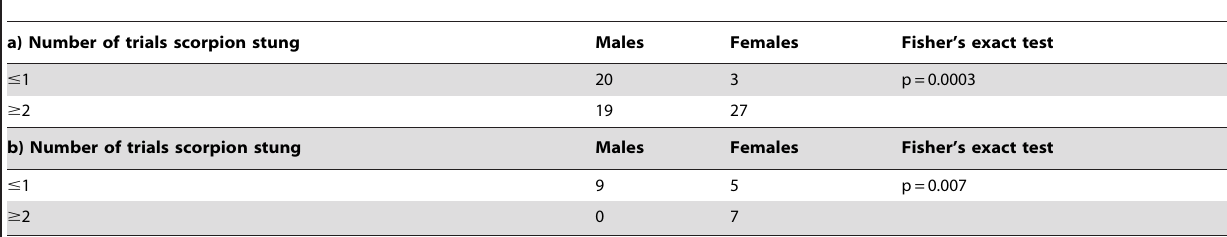
Table 2. Numbers of males and females which stung no more than once or at least twice during a) sting speed trials, and b) temperament